Question: Reading the figure, is the described quantity rising or falling?
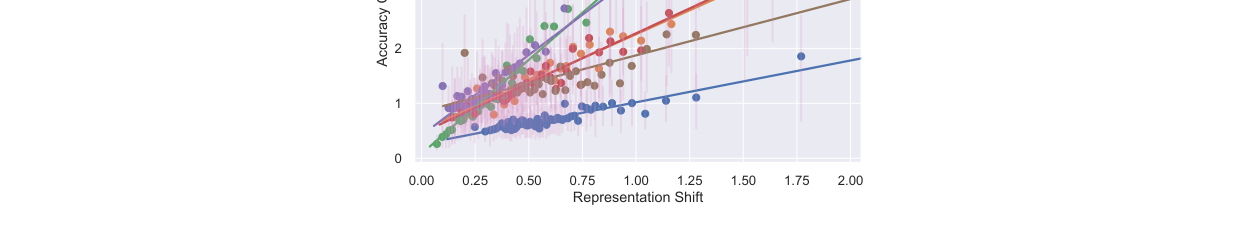
Answer: increasing